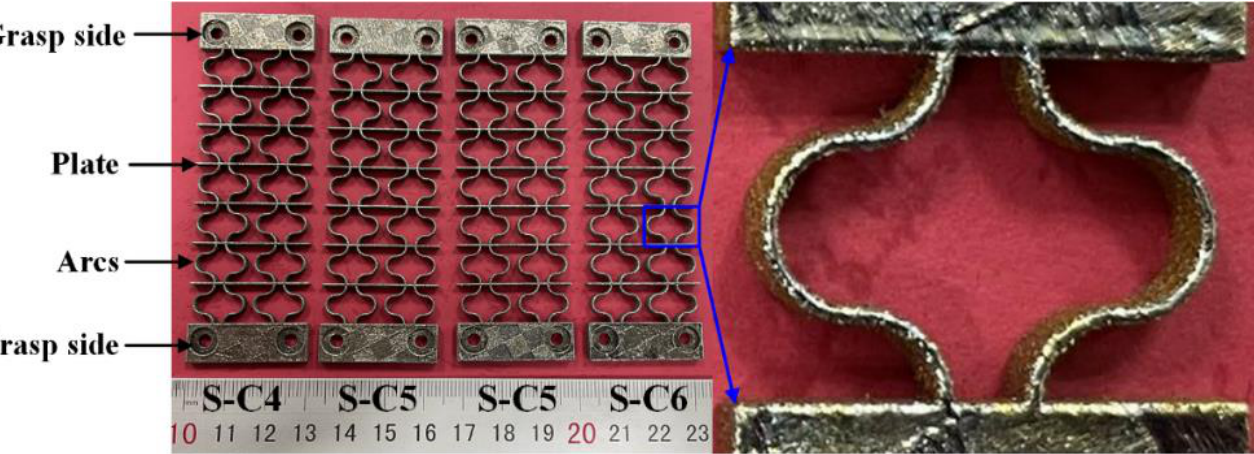
Figure 6. SLM – fabricated active SMA honeycomb arrays. Figure 6. SLM–fabricated active SMA honeycomb